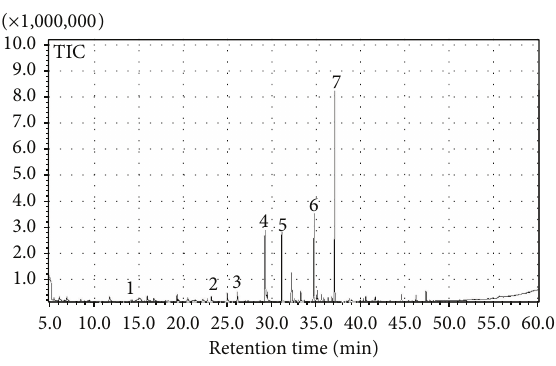
Figure 2: SPME-GC/MS traces of volatile fraction of black locust honey. (1) 3-Buten-1-ol-2-methyl ; (2) 3-buten-1-ol-3-methyl ; (3) 2- buten-1-ol-3-methyl ; (4) nonanal ; (5) cis-linalool-oxide ; (6) linalool ; (7) hotrienol